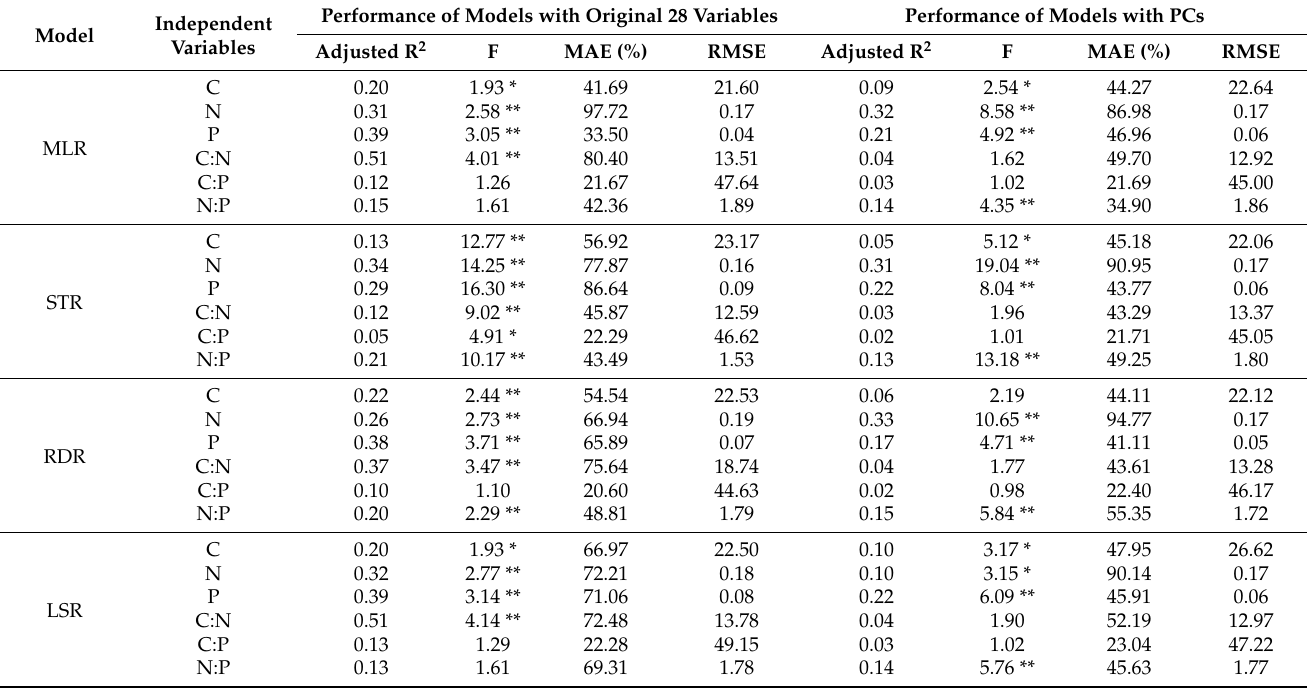
Table 5. Summary of regression